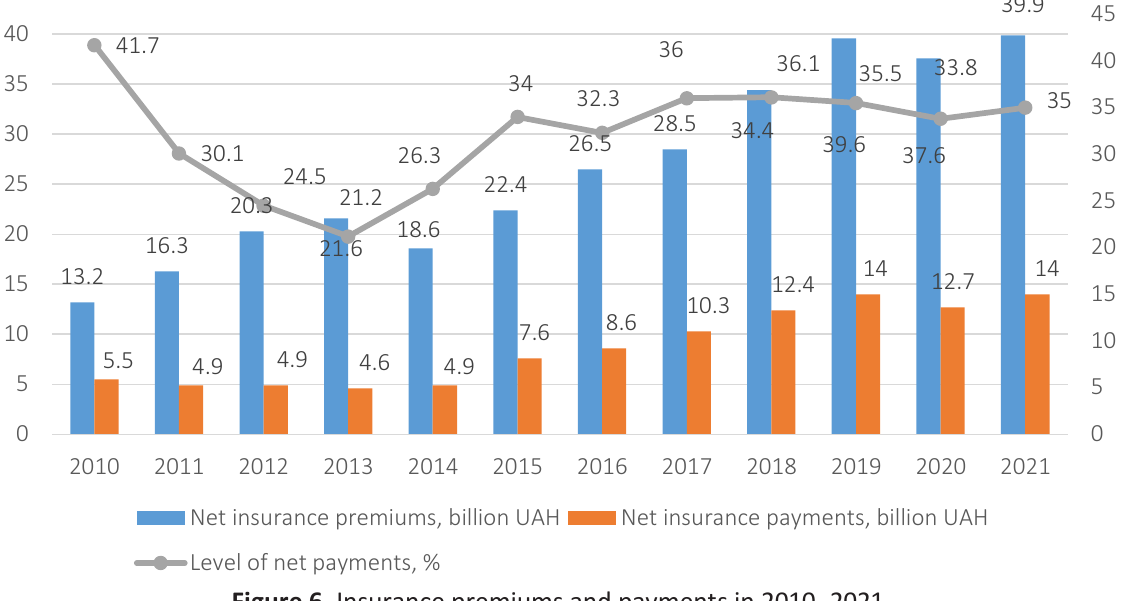
Figure 6. Insurance premiums and payments in